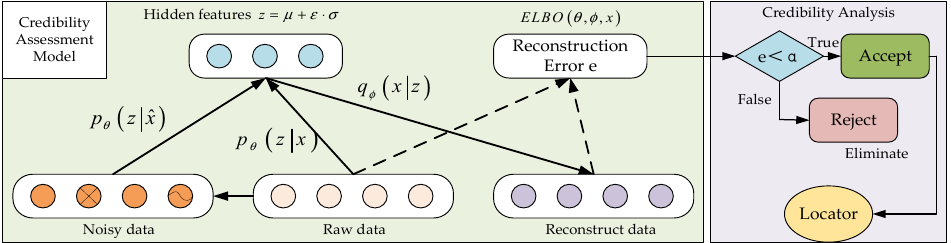
Figure 11. Multi-dimensional atlas credible assessment model.